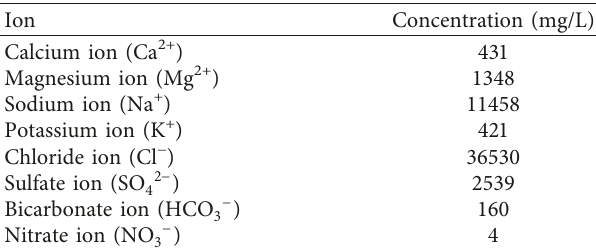
Figure 2: Schematic diagram of electrochemical accelerated cor- rosion device. Table 2: Testing table for seawater composition used in the